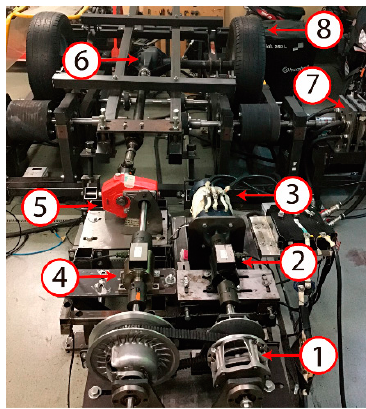
Figure 16. Testing bench: active dynamometer.